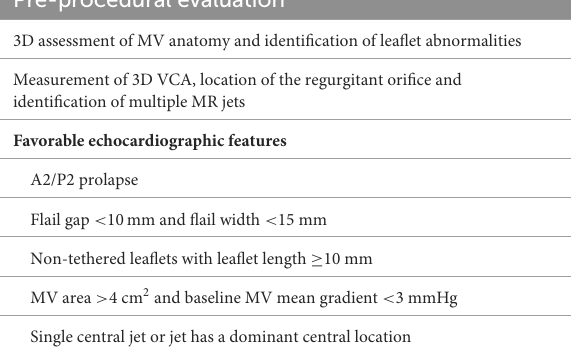
TABLE 3 Role of echocardiography for planning and guiding transcatheter edge-to-edge leaflet repair in mitral valve prolapse. Pre-procedural